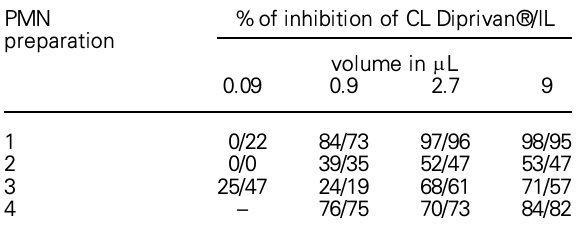
Table 1. Effects of Diprivan® on the chemiluminescence (CL) of 10 –6 MPMA stimulated PMN: comparison with the effects of intralipid (IL), the vehicle solution of PPF in